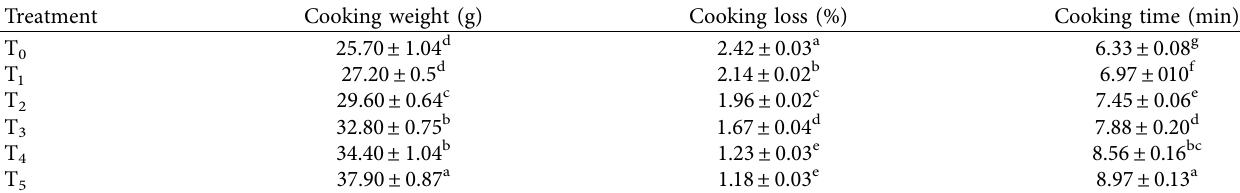
Values arepresentedas means ± SD ( n � 3). Valueshaving similar lettering ineach column shownon-significance at p > 0 . 05 T 0 � 100%fine wheatflour–based noodles (control), Table 2: Functional properties of fine wheat flour (FWF), fenugreek seed powder (FSP), and supplemented composite noodles (g/100 g). Treatment